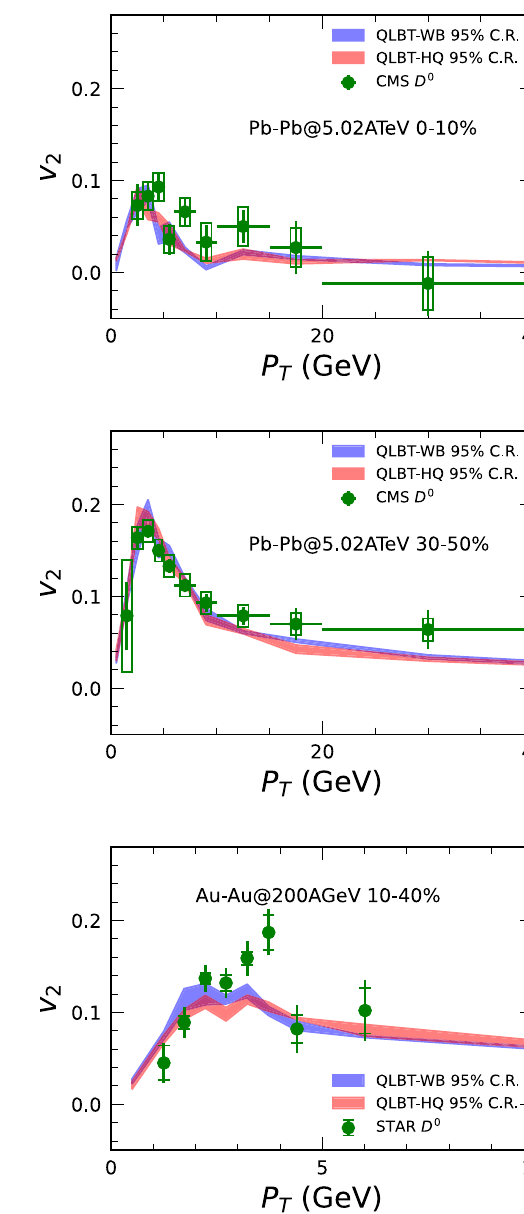
RHIC are compared to the experimental data from CMS Collaboration √ s NN = [123,124] and STAR Collaboration √ s NN = 200 GeV at